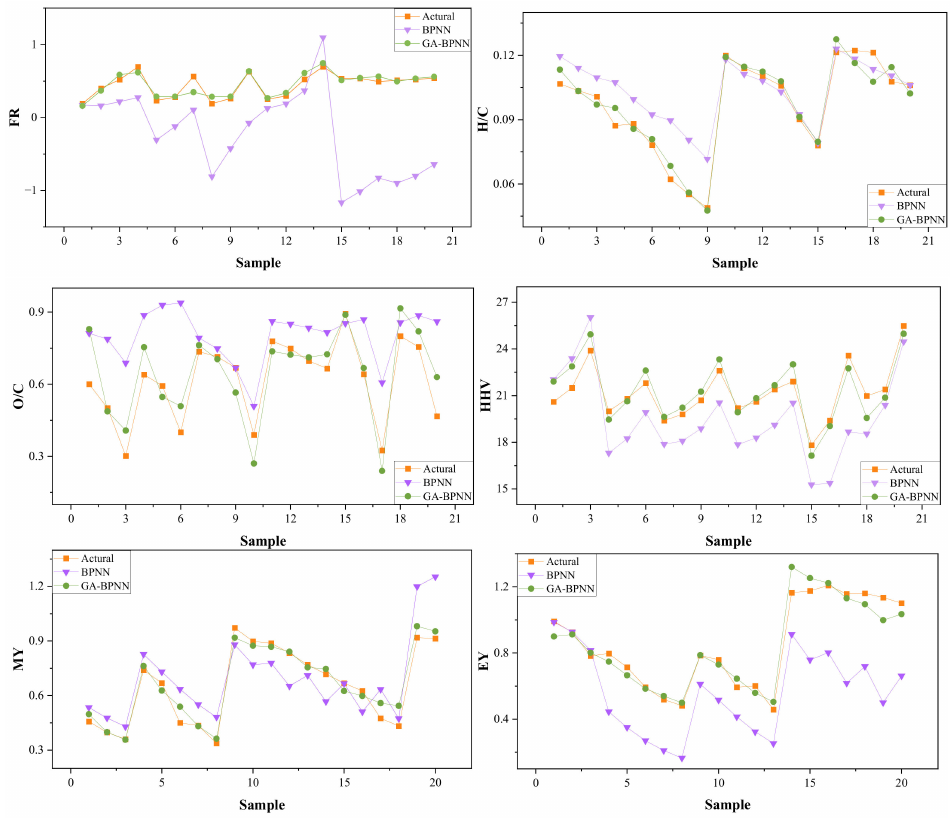
Figure 6. Comparison between the actual and BPNN/GA-BPNN predicted output variables of the testing